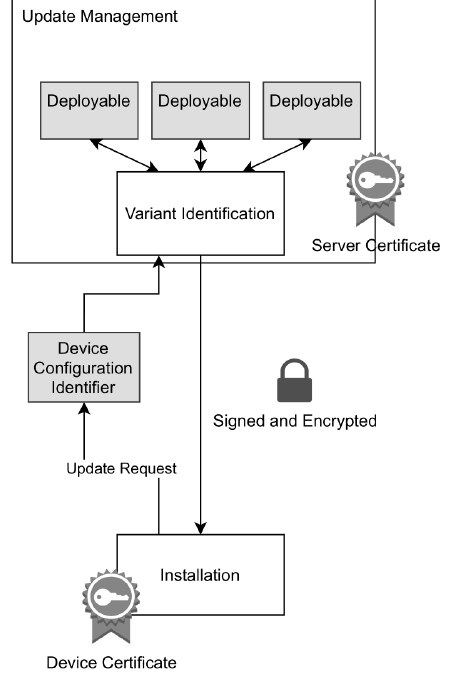
Figure 9. Signed and Encrypted Deployment of the